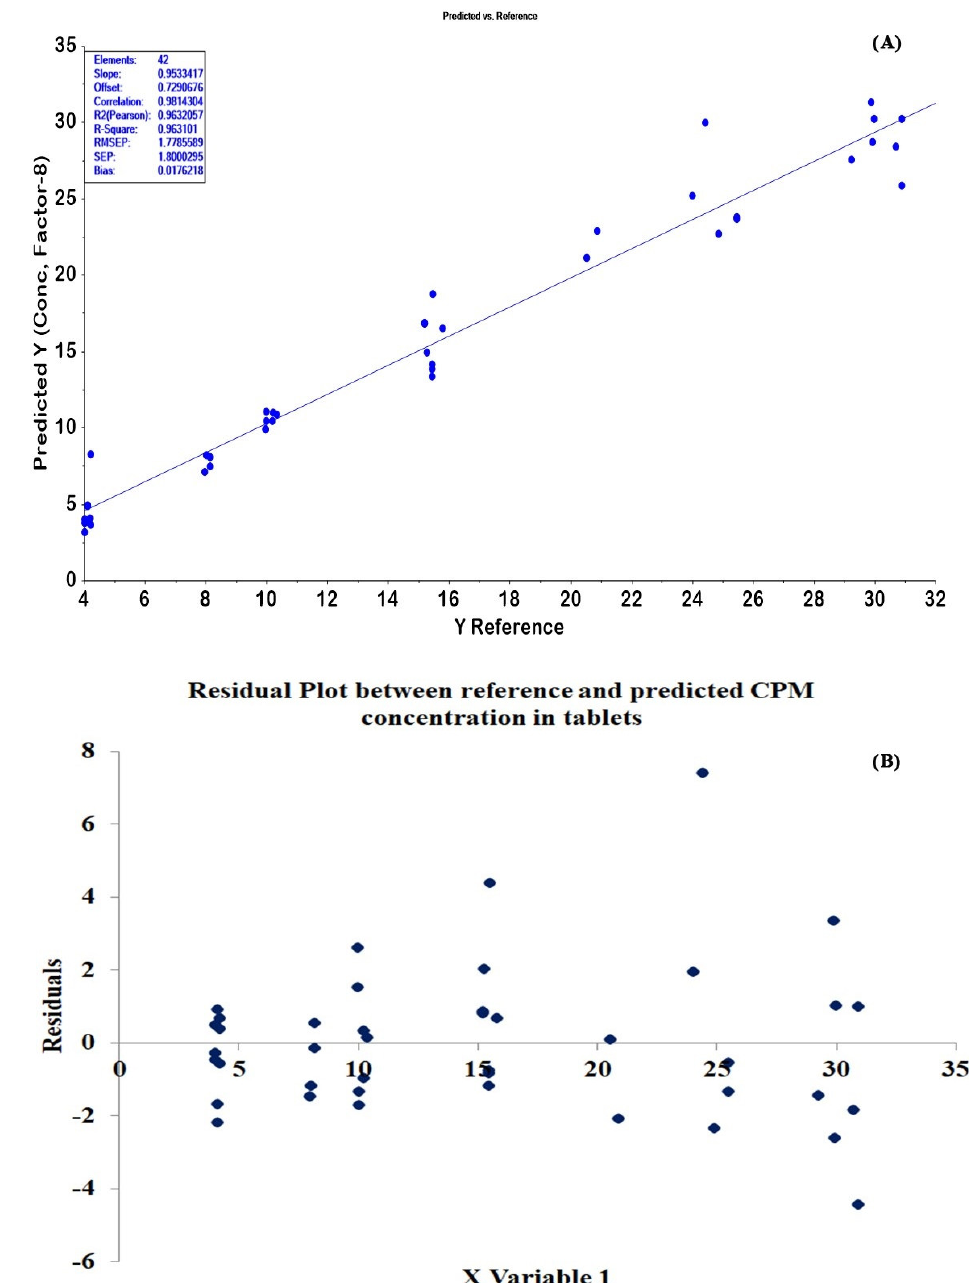
Figure 6. ( A ) The correlation plot between reference and predicted CPM contents of test set samples for tablets showed the slope close to 1, a good R 2 (Pearson), low RMSEP and bias. ( B ) The residuals plots of the prediction values compared with reference values showed a little heteroscedasticity for the high